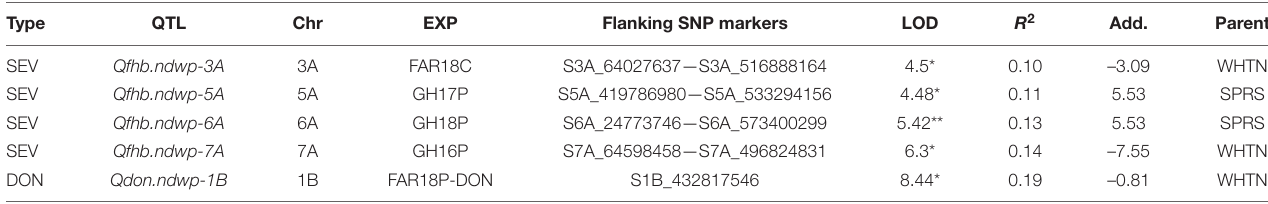
TABLE 4 | Summary of QTL detected for FHB severity (type II resistance) and DON accumulation (type III resistance) by composite interval mapping (CIM) in the Wheaton/Surpresa RIL population.